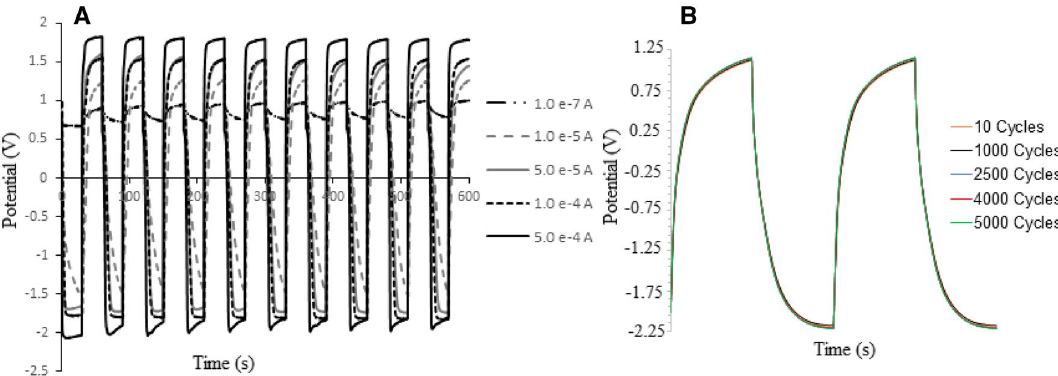
Figure 5. Diagrams of potential vs. time (charge/discharge-time curves) of Salen polymer as nanowires modified on GC electrode at different applied electrical currents (ranged between 1.0 × 10 −7 to 5.0 × 10 −4 A) and various CV cycles up to ( A ) 500 and ( B ) 5000